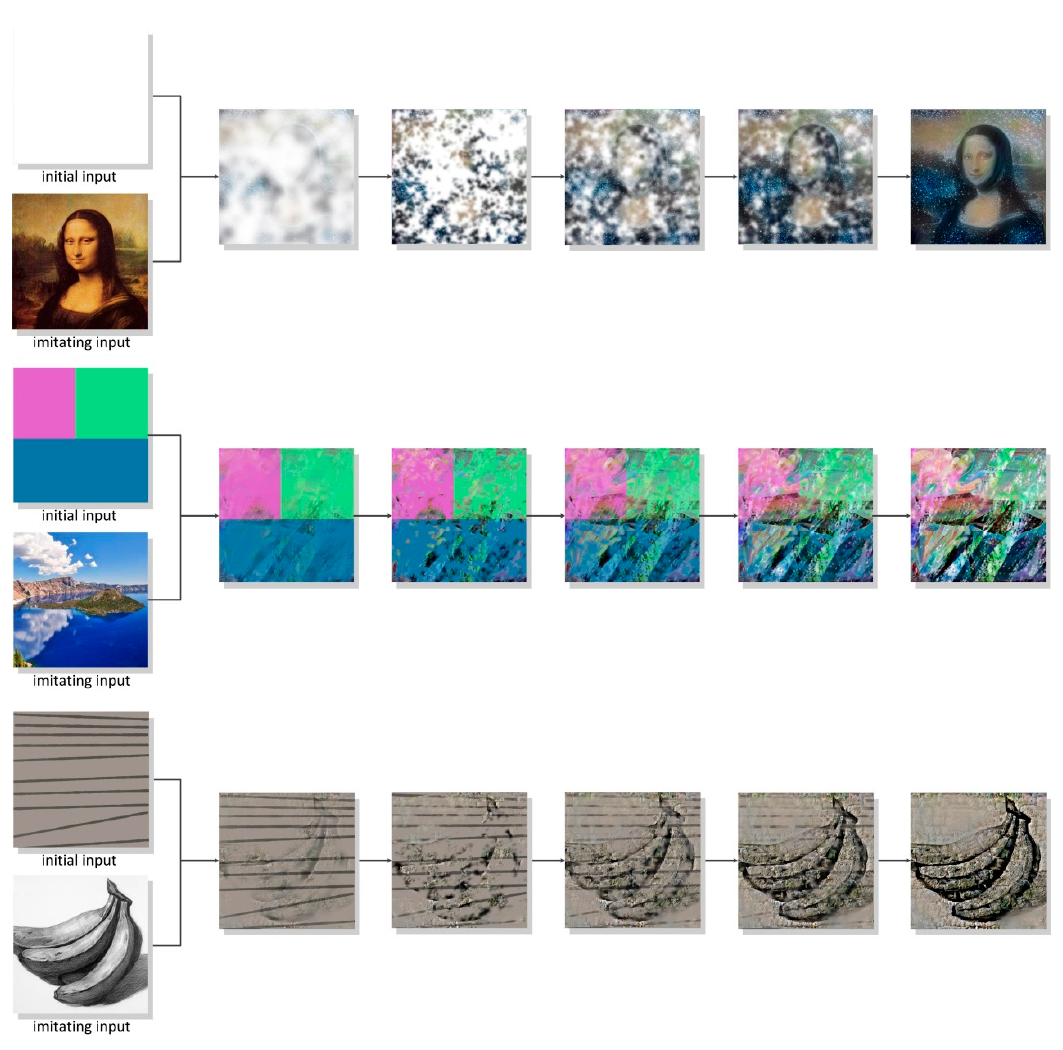
Figure 4. Imitating evolutionary art with a target.